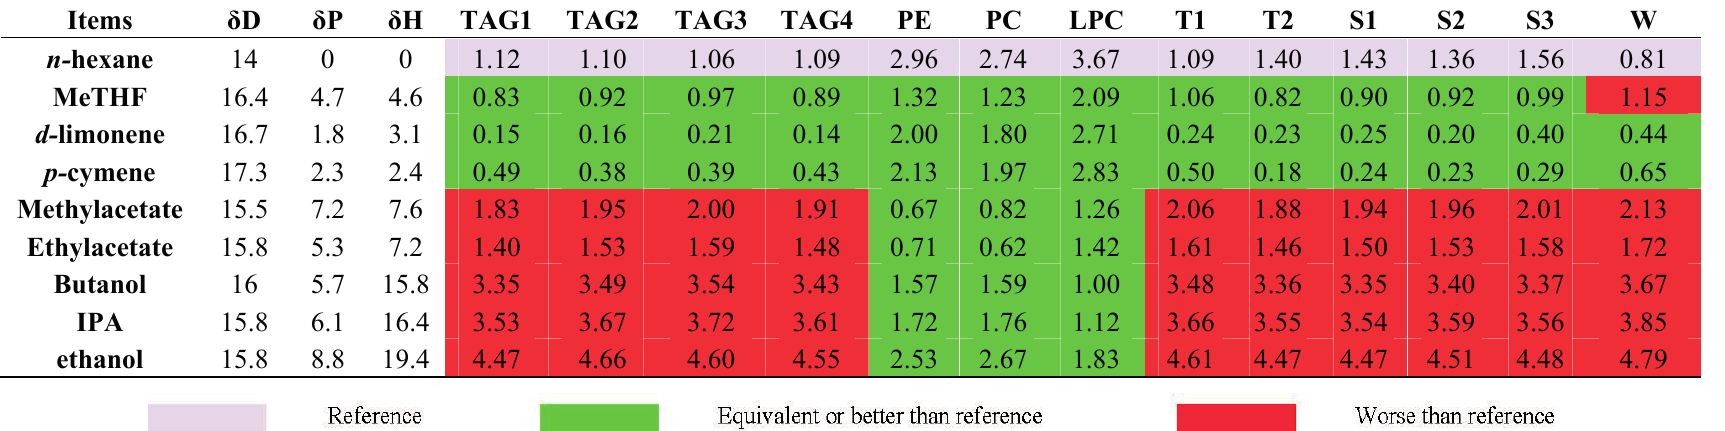
Table 2. The relative energy difference (RED) values for HSP assisted selection of alternative solvent to n -hexane for the extraction of rapeseed